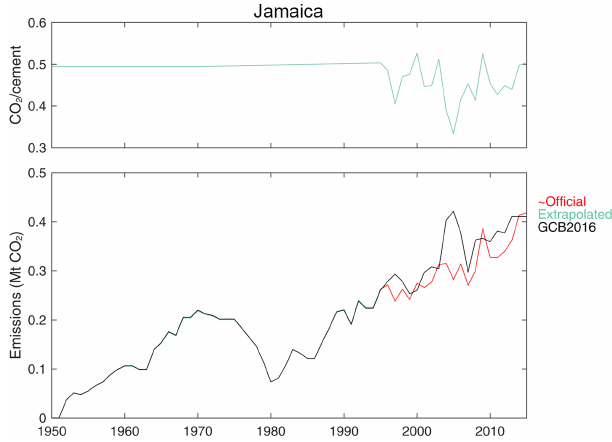
Figure D21. Revised cement emissions for Jamaica.